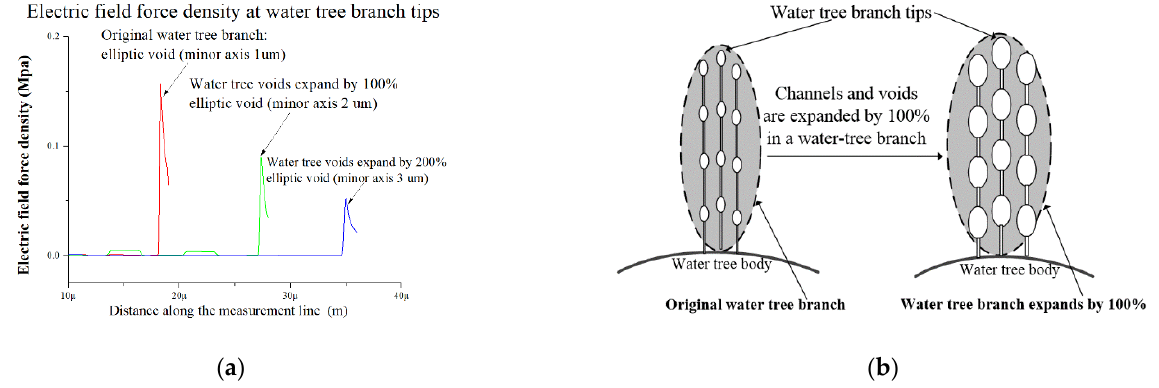
Figure 10. Electric field force density and expansion of water tree branches at higher temperature: ( a ) Electric field force density at water tree branch tips; ( b ) Expansion of water tree branches at a higher temperature.